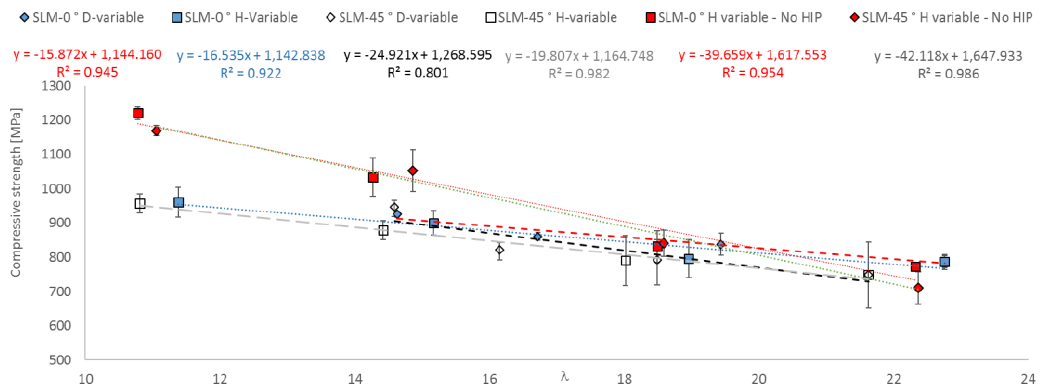
Figure 18. Correlation between compressive strength and slenderness ratio of SLM-manufactured parts. Results are shown as mean values with the corresponding standard deviations. For the linear regressions, the coefficient of determination is shown.